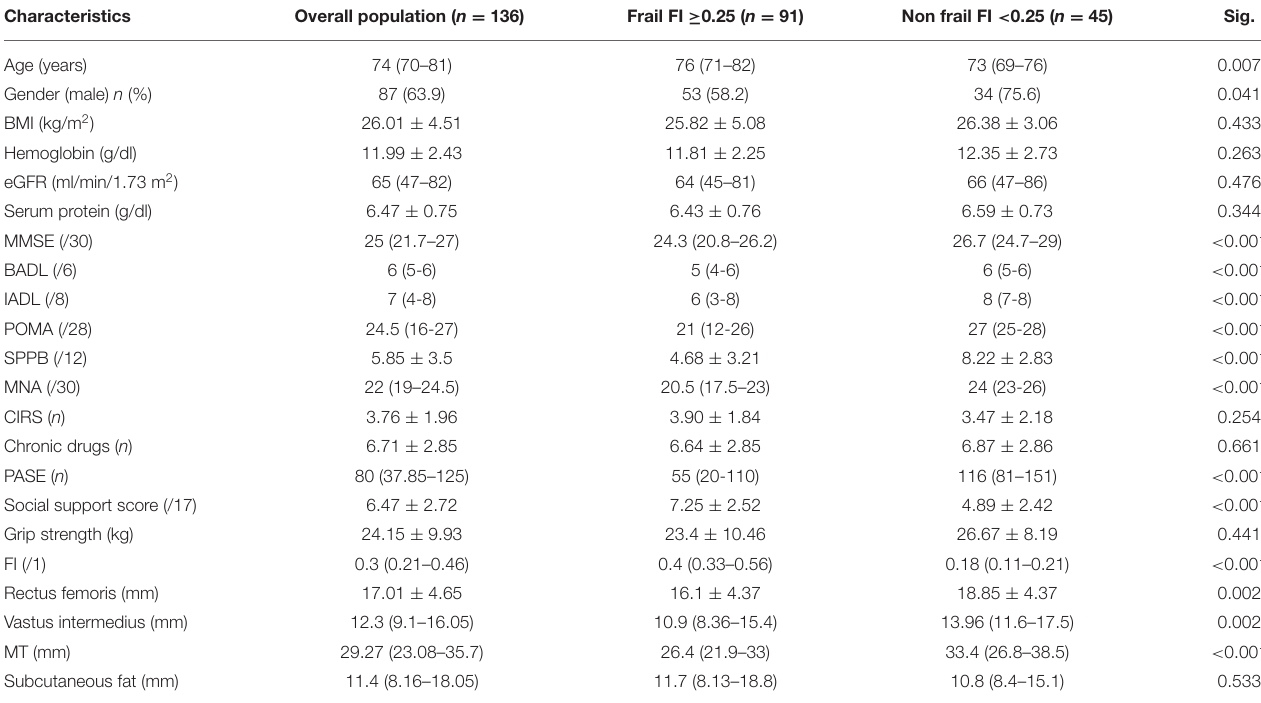
TABLE 3 | Characteristics of the overall population and of subgroup according to frailty status.